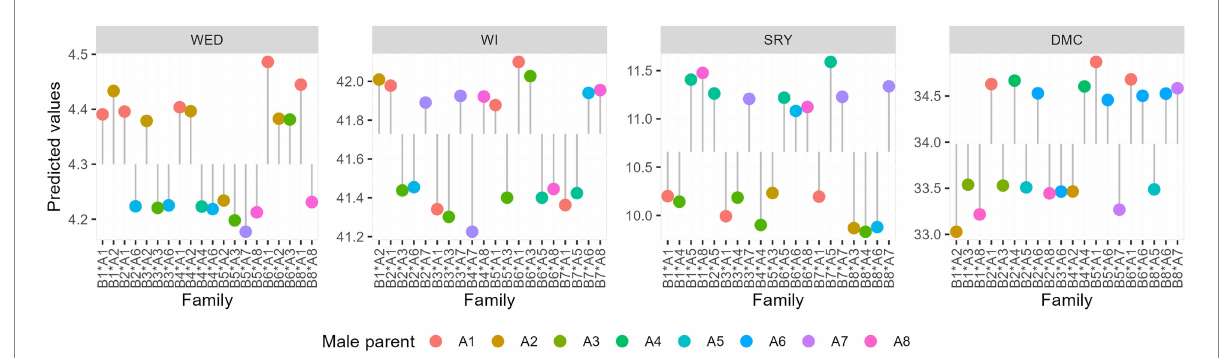
FIGURE 2 Best and worst performing families based on best linear unbiased predictors (BLUPs) for weevil severity, weevil incidence, storage root yield, and dry matter content across four